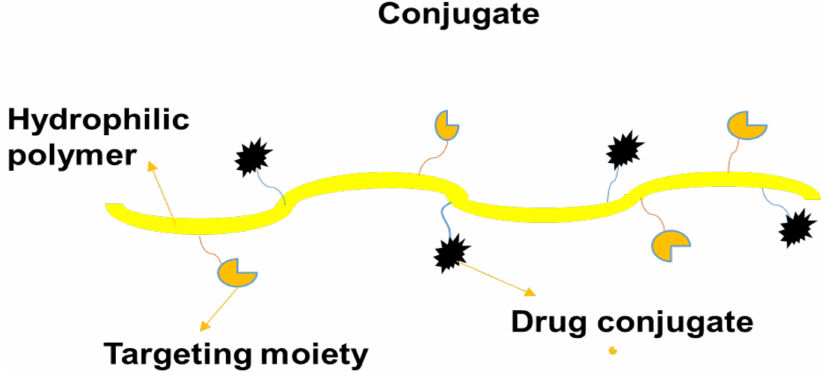
Figure 5. A schematic diagram of a